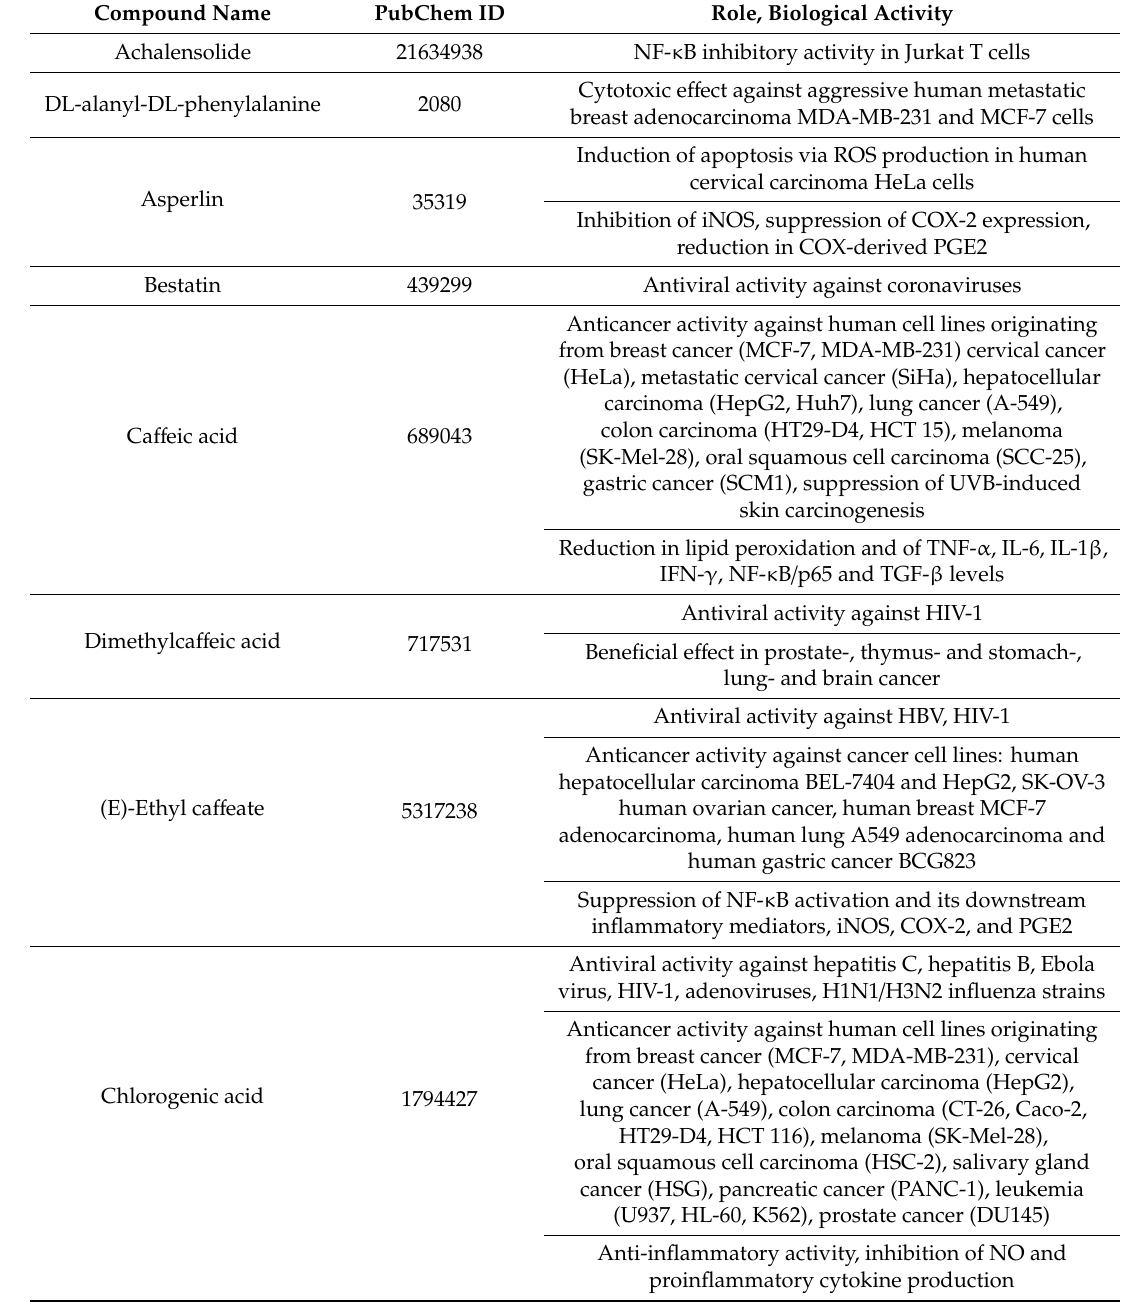
Table 1. Antiviral, anticancer and anti-inflammatory roles of representative compounds found in wine. The full list of the compounds with detailed biological role and references are listed in Table